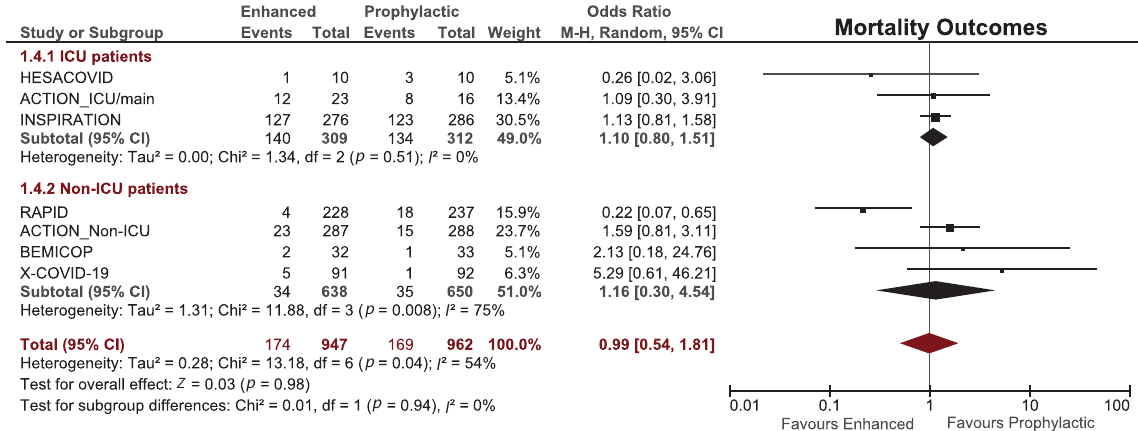
Fig. 5 Subgroup analysis of mortality outcomes in ICU and non-ICU patients who received enhanced (therapeutic/intermediate) versus prophylactic anticoagulation. CI, con fi dence interval; ICU, intensive care unit.